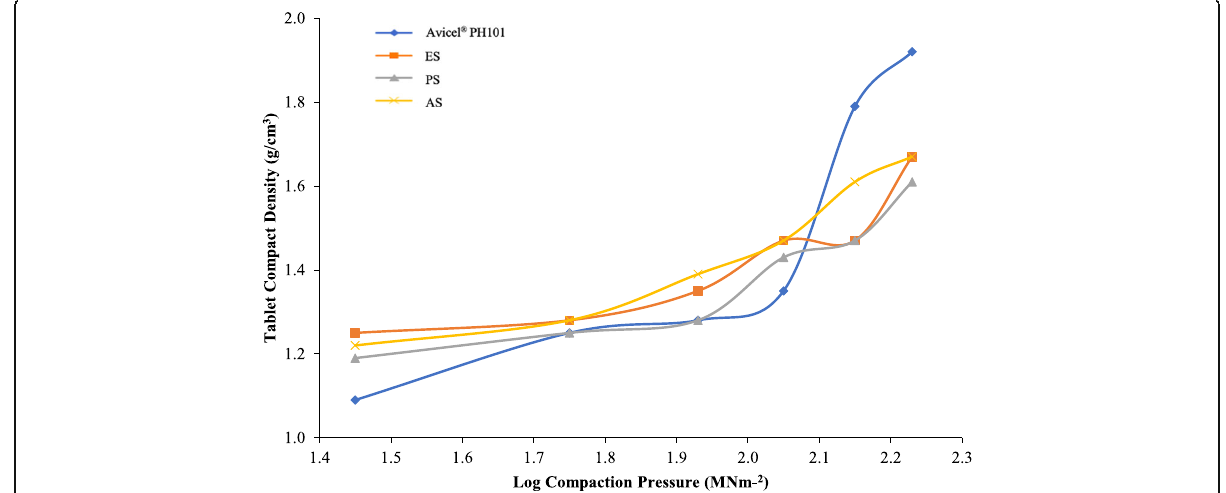
Fig. 3 Profiles for compressibility indices of modified starches (ES, PS, AS) and Avicel® PH101 of compact excipients as